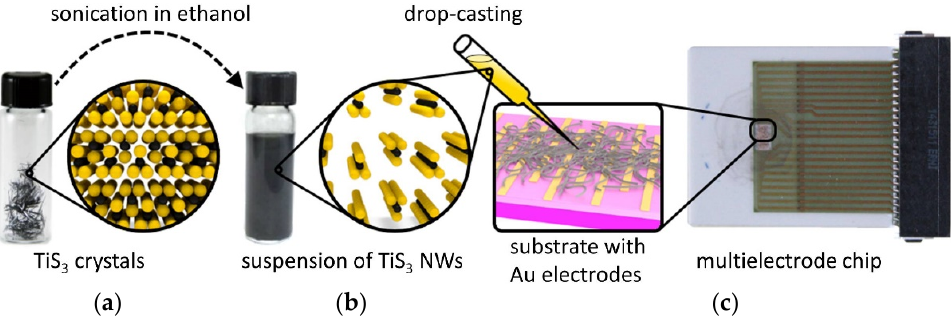
Figure 1. Fabrication of chemiresistive gas sensors based on TiS 3 NWs. ( a ) Optical photograph of as-grown TiS 3 crystals. The scheme shows a fragment of the crystal structure of TiS 3 . Yellow spheres—sulfur; black spheres—titanium. ( b ) Optical photograph of the dispersion of TiS 3 crystals in ethanol. The scheme shows 1D TiS 3 chains that were exfoliated from bulk crystals by ultrasonication. ( c ) Optical photograph of a multielectrode sensor chip. The scheme shows the drop-casting of the TiS 3 suspension on the electrode area of the chip.